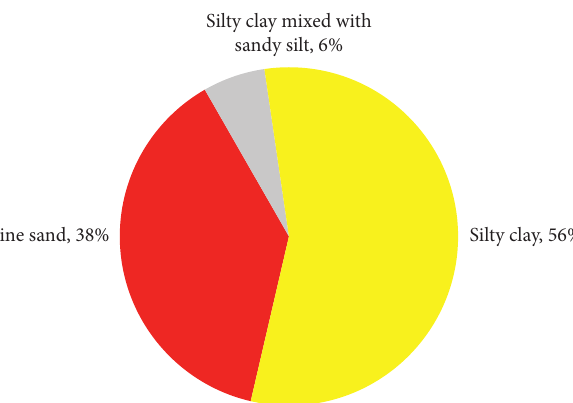
Figure 1: The proportion of strata that the shield